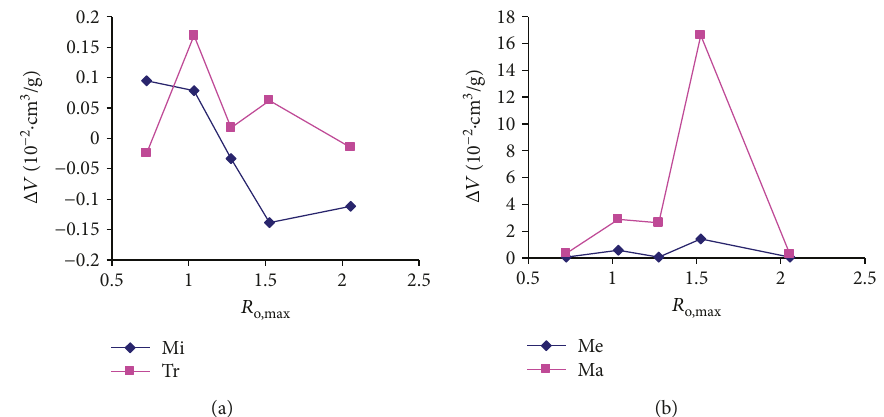
Figure 3: Plots of the changes in pore volume with coal rank: (a) pore volume change in micropore and transitional pore and (b) pore volume change in mesopore and macropore.